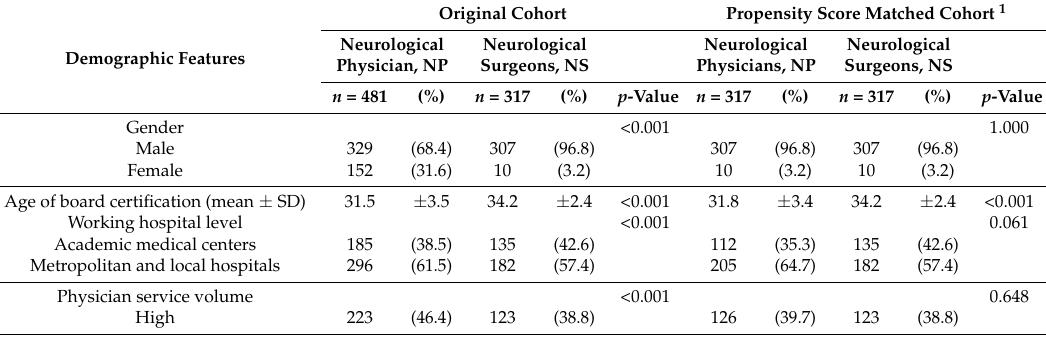
Table 1. Demographic features between neurological physicians (NP) and surgeons (NS) in original cohort and propensity score matched cohort